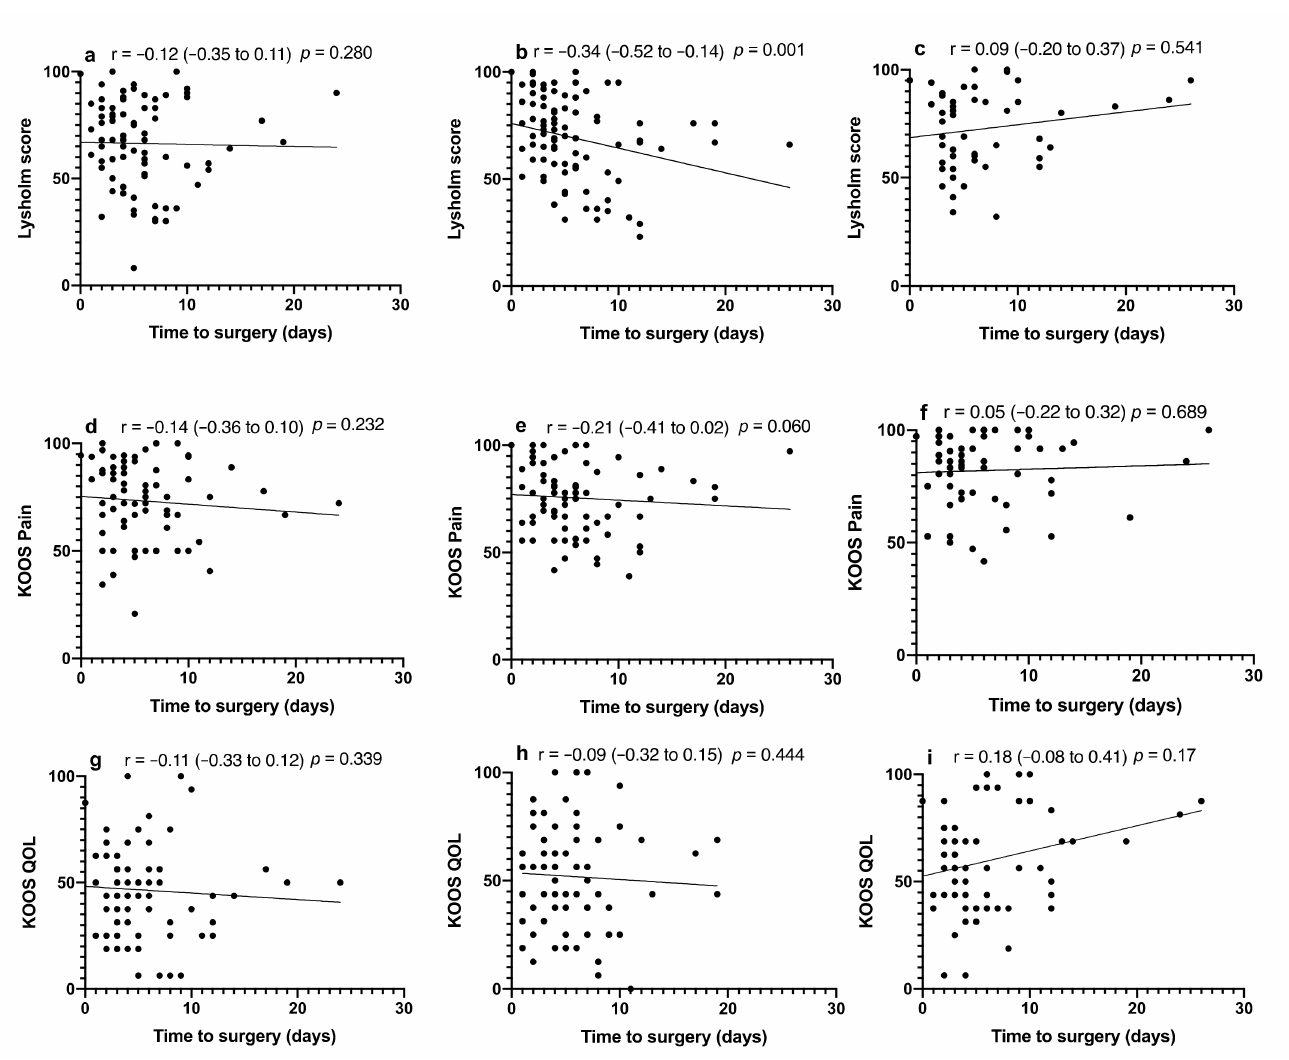
Figure 3. Effect of time to theatre on patient-reported outcome score. Lysholm score at ( a ) 6 months, ( b ) 12 months, and ( c ) medium term. KOOS Pain at ( d ) 6 months, ( e ) 12 months, and ( f ) medium term. KOOS QOL at ( g ) 6 months, ( h ) 12 months, and ( i ) medium term. Spearman correlation coefficients with respective confidence intervals are reported for each